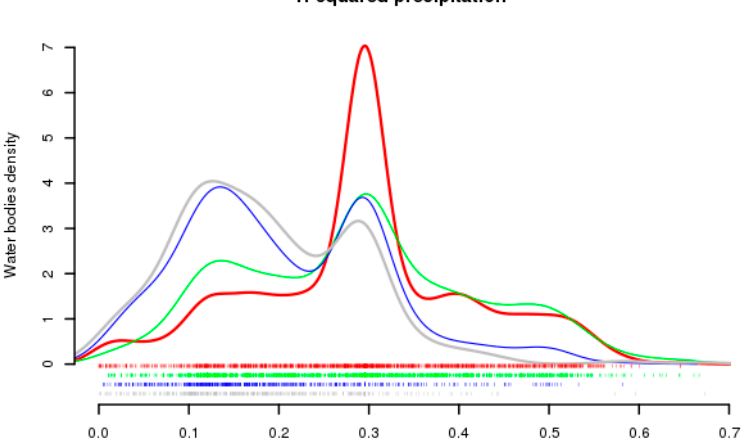
Figure 6. Density plot of the mean R-squared value of water bodies. The R-squared comes from an ordinary least squares regression between mean annual accumulated precipitation on the aquifer and mean hydroperiod of the pixels classified as temporary waters. Higher values indicate greater dependence of hydroperiod from annual precipitation. Arcsine transformed mean R-squared values on the X axis (radians). Protection level indicated with colors: high protection = red, medium protection = green, low protection = blue, unprotected = gray. The rug plots below indicate the distribution of water bodies. High protection (red) and unprotected (gray) lines are drawn thicker for clarity.